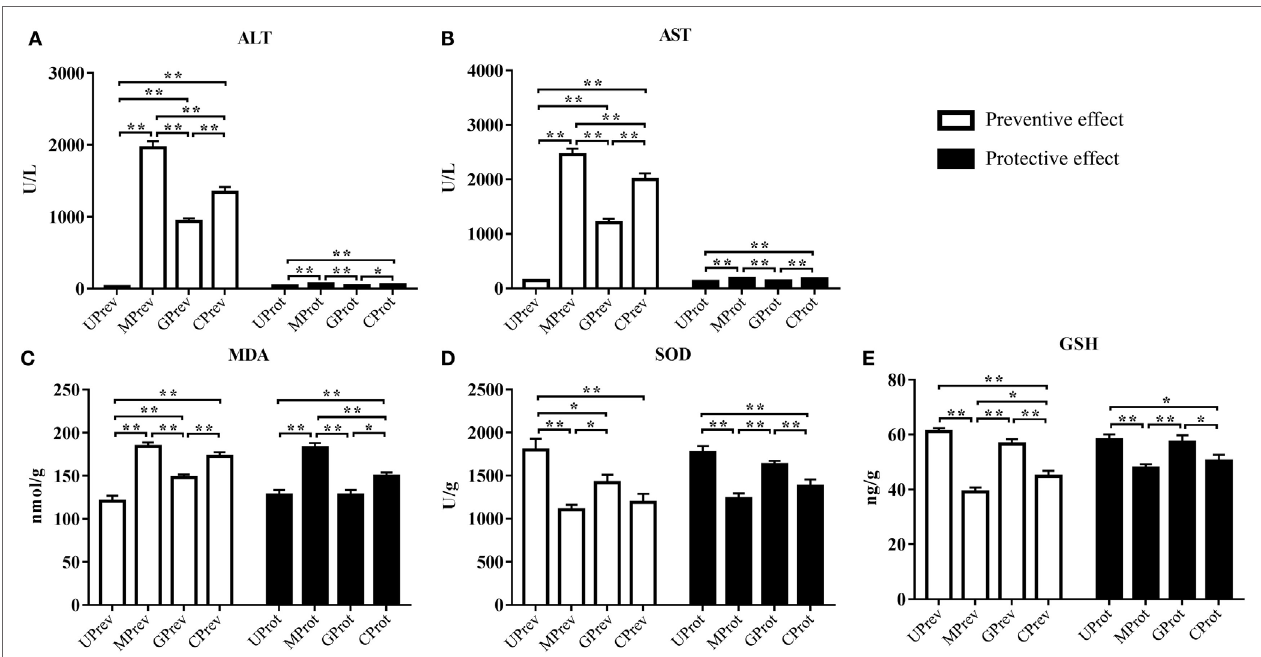
FigUre 2 | Levels of five biochemical indices in samples from mice in the eight different treatment groups (see Figure 1a ). Samples were taken 1 day after administration of CCl 4 (to determine preventive effects of milk consumption on induced liver injury) from: untreated control mice (UPrev), model mice (MPrev), mice receiving goats’ milk (GPrev), and mice receiving cows’ milk (CPrev) and 8 days after administration of CCl 4 (to determine protective effects of continued milk consumption on induced liver injury) from untreated control mice (UProt), model mice (MProt), mice receiving goats’ milk (GProt), and mice receiving cows’ milk (CProt). The indices were as follows: alanine transaminase (ALT) (a) , aspartate transaminase (AST) (B) , malondialdehyde (MDA) (c) , superoxide dismutase (SOD) (D) , and glutathione (GSH) (e) . The data and error bars are presented as mean ± SEM. * P < 0.05; ** P <